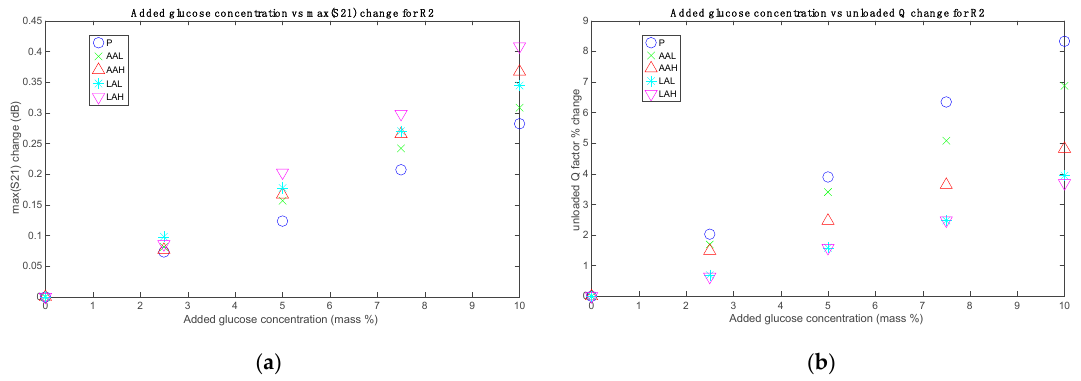
Figure 5. ( a ) Measurements with R2: absolute changes for S21 max ; ( b ) Measurements with R2: percentage changes for Q u .